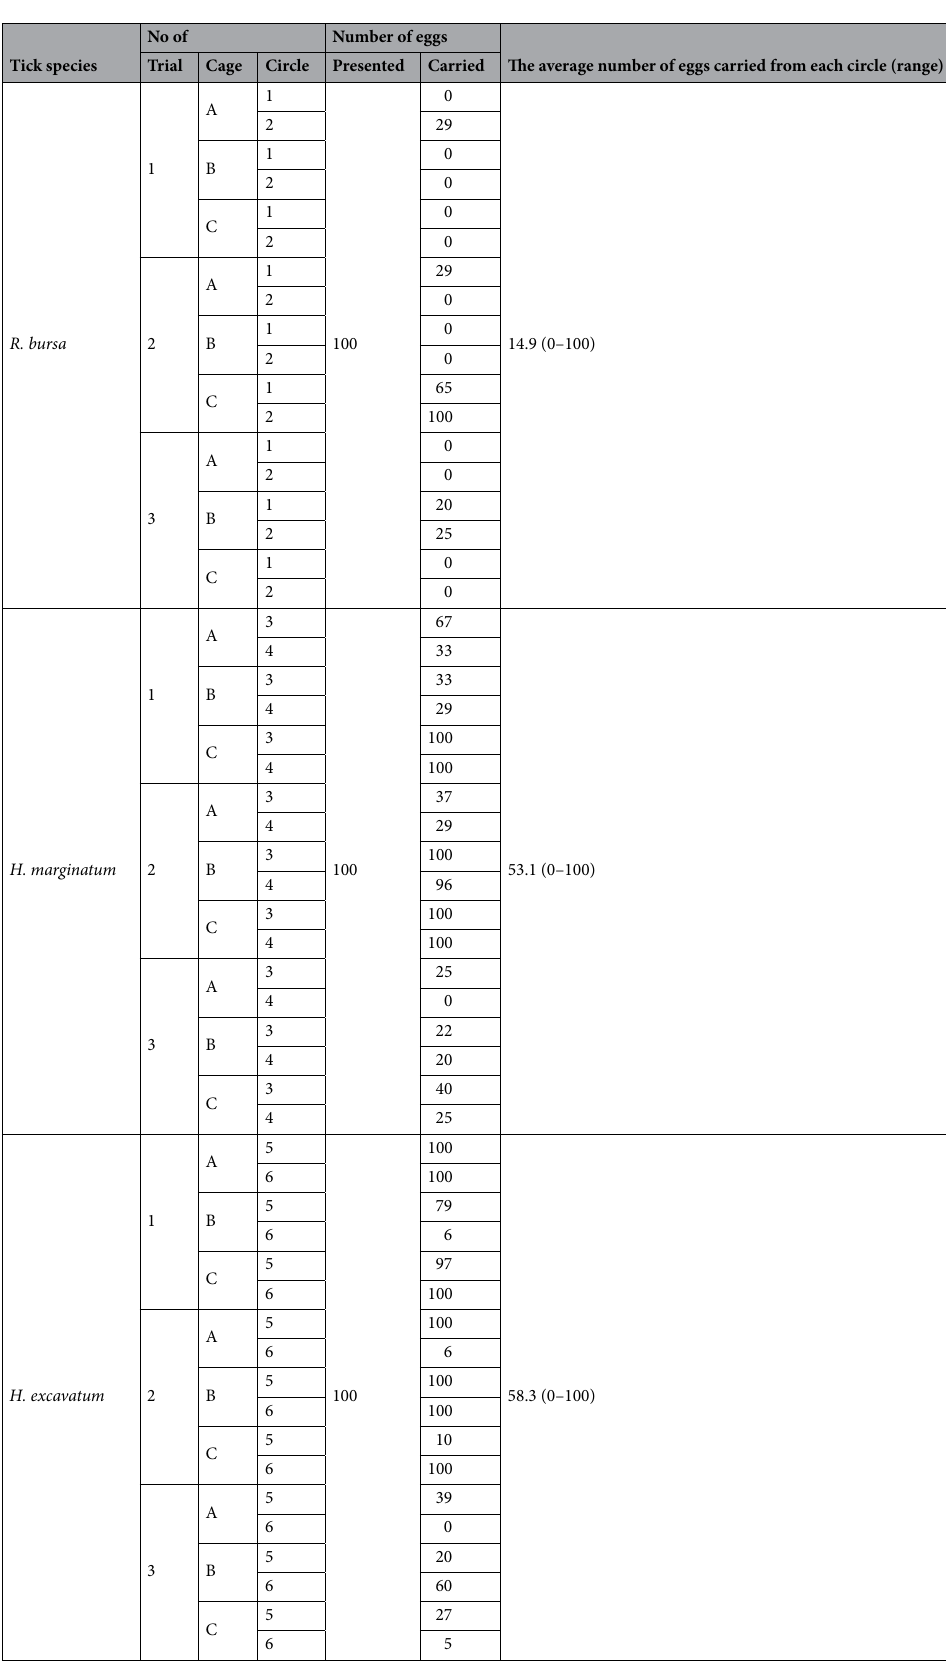
Table 1. The number of the waxed tick eggs carried by the ants within 24 h in Experiment